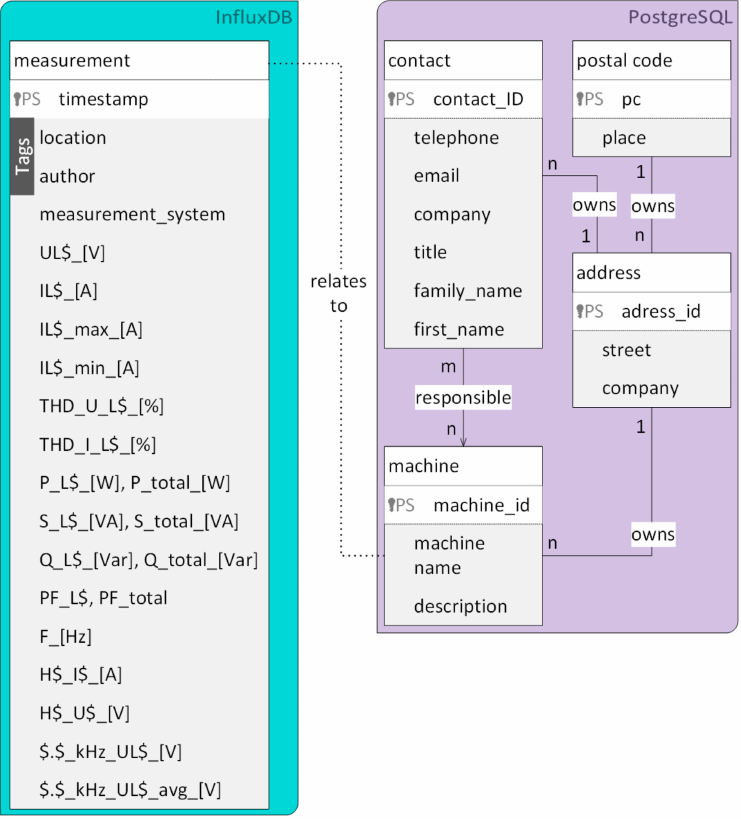
Figure 10. Combination of InfluxDB and PostgreSQL for data storage and capturing of the metadata of the stored